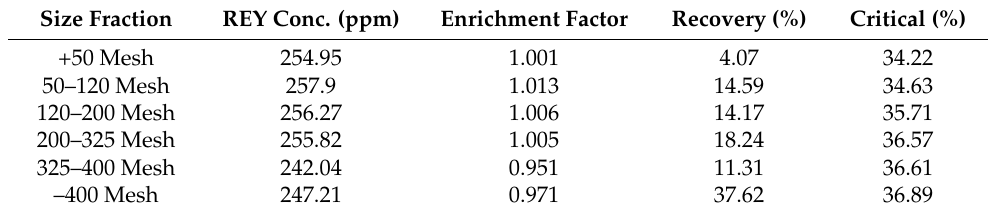
Table 2. Size separation